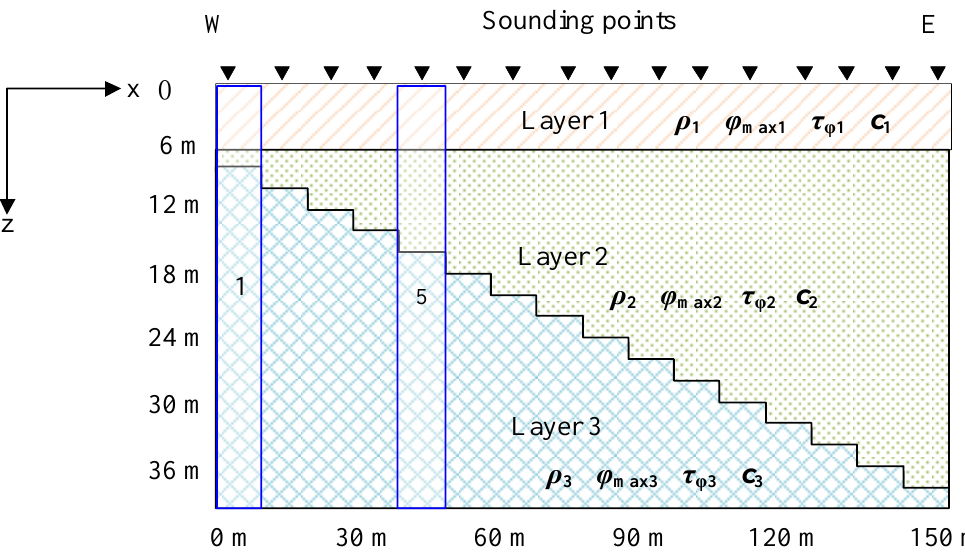
Figure 3. Synthetic models and sounding points. For example, the blue boxes present model 1 and model 5. Table 1. The parameters of the synthetic three-layered chargeable models.